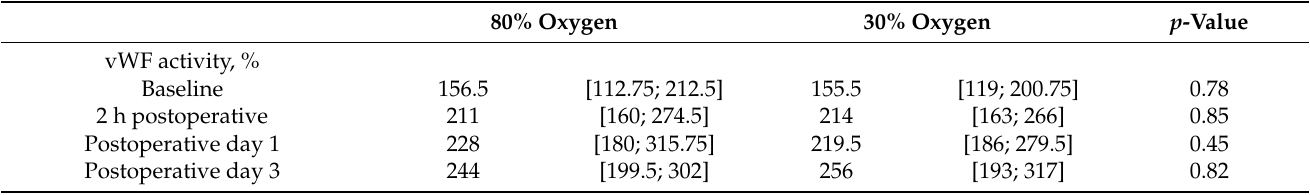
Table 1. Descriptive statistics for vWF activity and Ristocetin cofactor activity. VWF activity